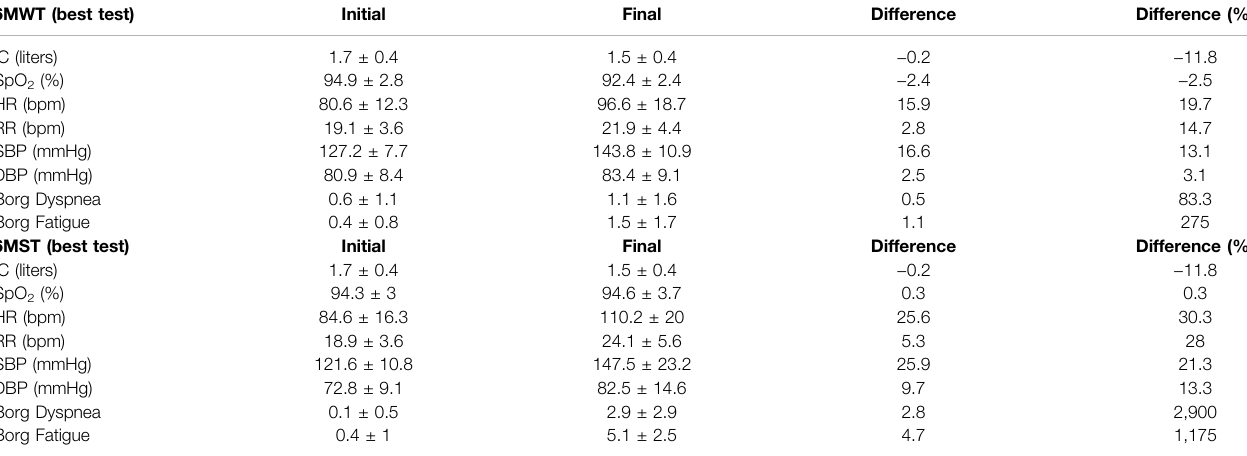
TABLE 3 | Physiological and perceptual parameters at rest (initial) and the end ( fi nal) of the best tests (6MWT and 6MST) performed.